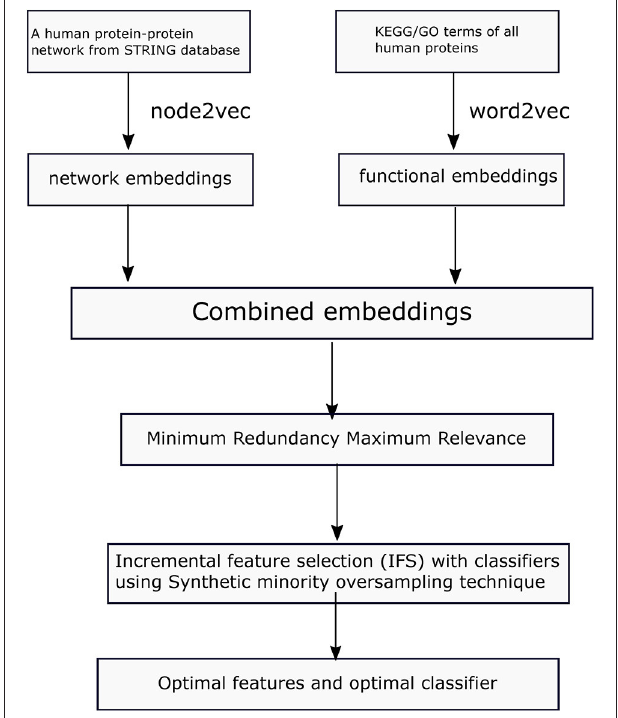
FIGURE 1 | Flowchart of the proposed method in this study.